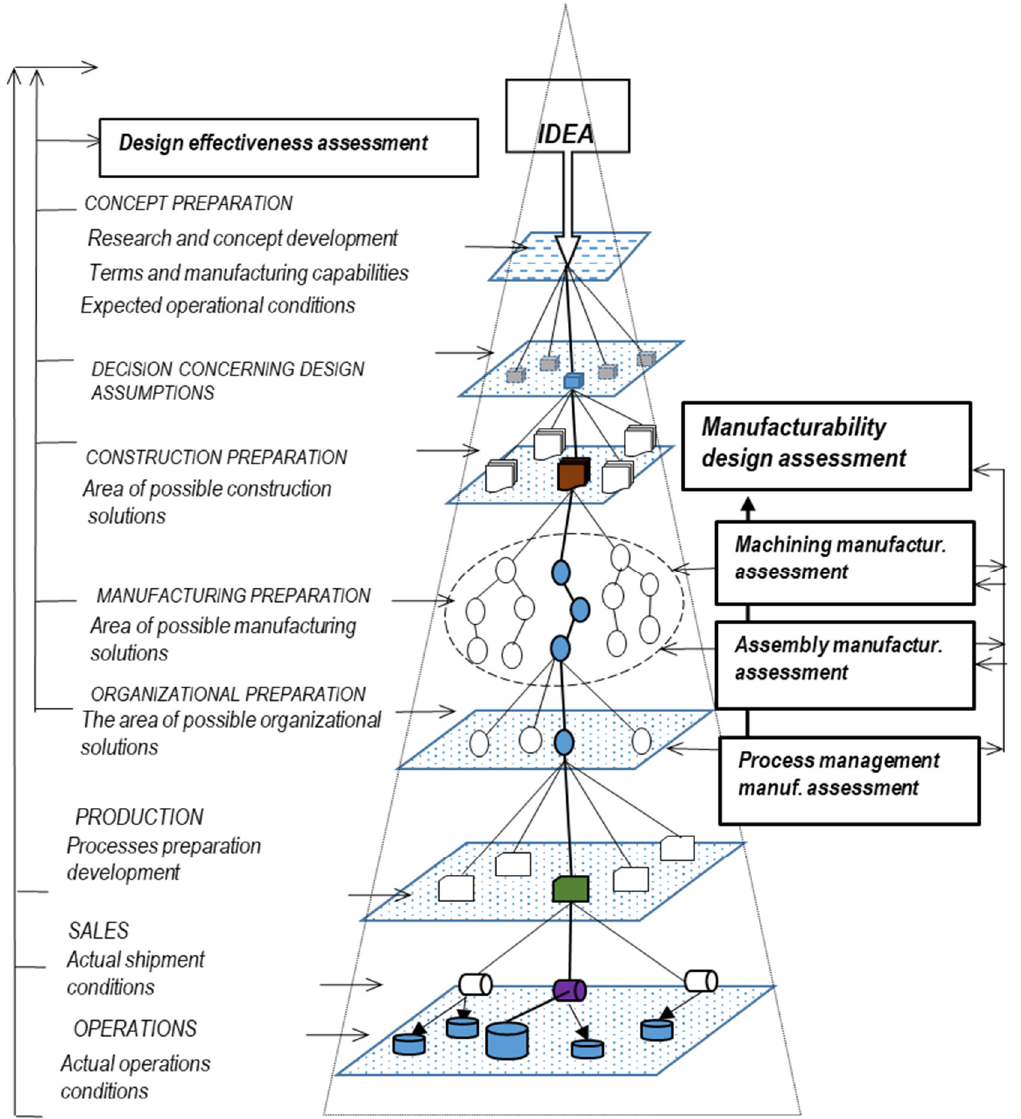
Figure 1. Modified design and development process to produce a new product.